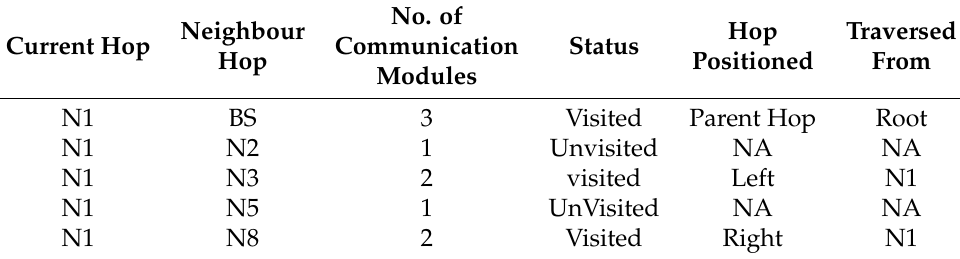
Table 4. The updated right subtree routing of N2.